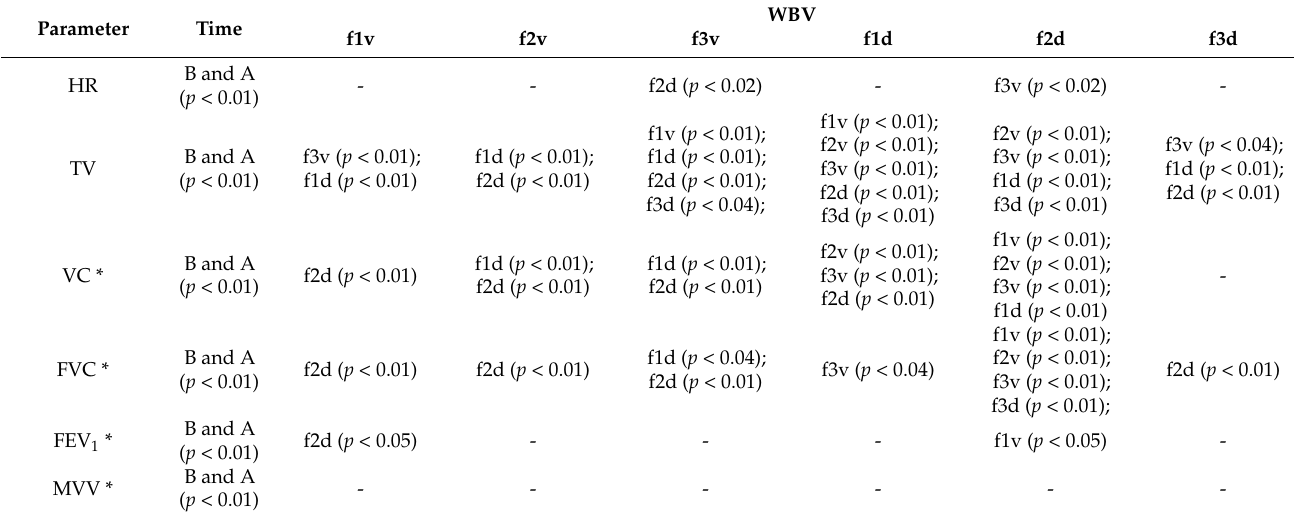
Table 4. Results of Bonferroni post hoc